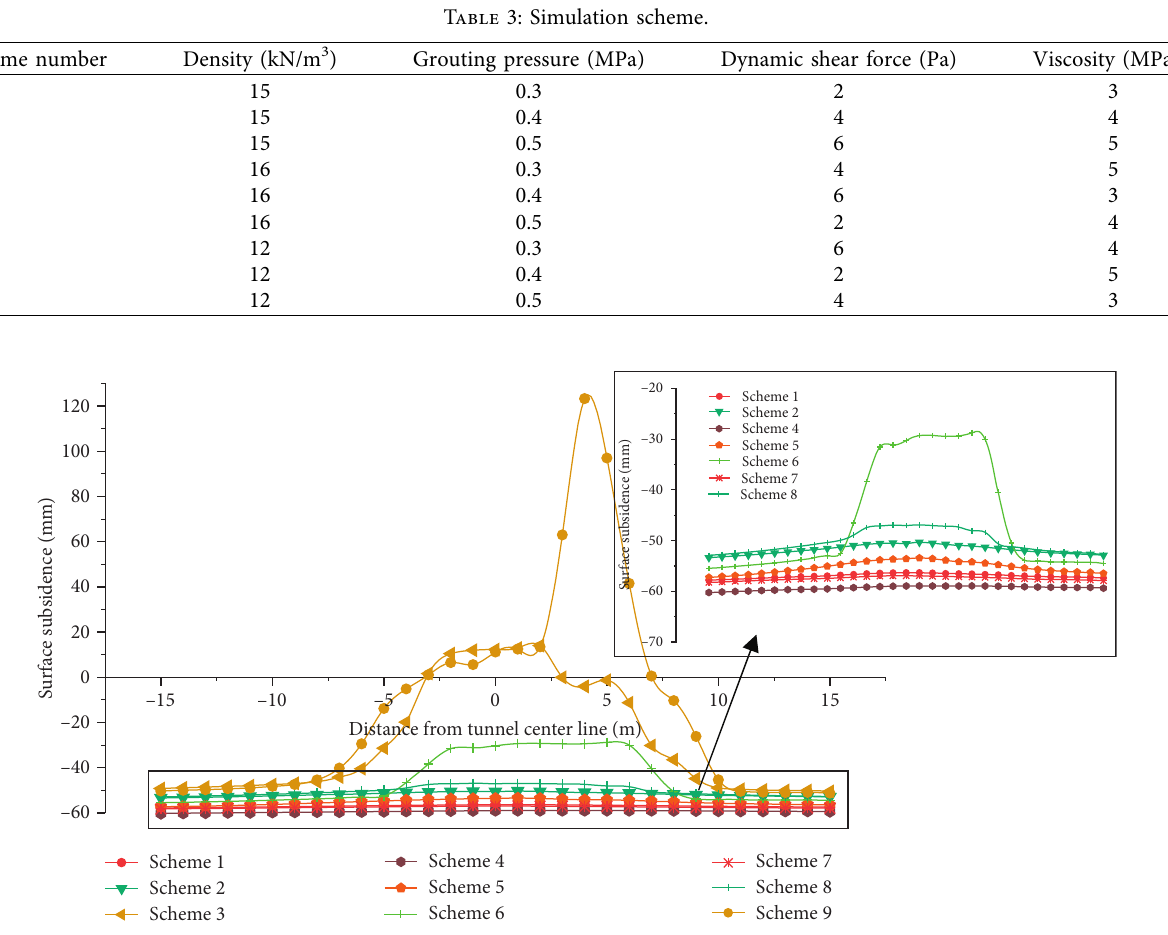
Figure 4: Surface settlement